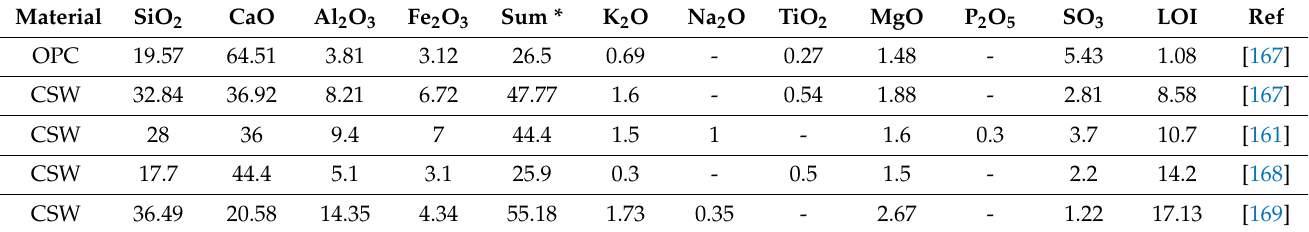
Table 14. Comparison of chemical compositions of CSW with OPC. (Note: Sum * is the sum of pozzolanic